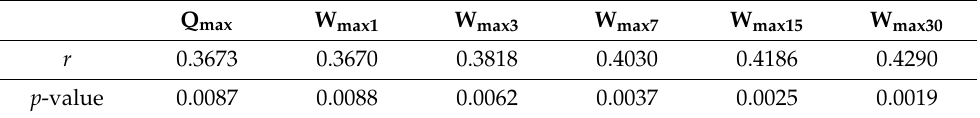
Table 2. Summary for the correlation between the mean temperature series in July and August and the snowmelt flood characteristic series: r represents the Pearson correlation coefficient; p -value means the significance value; Q max means the measured annual maximum peak discharge; W max1 , W max3 , W max7 , W max15 , and W max30 mean the annual maximum 1, 3, 7, 15 and 30-day flood volume, respectively. Q max W